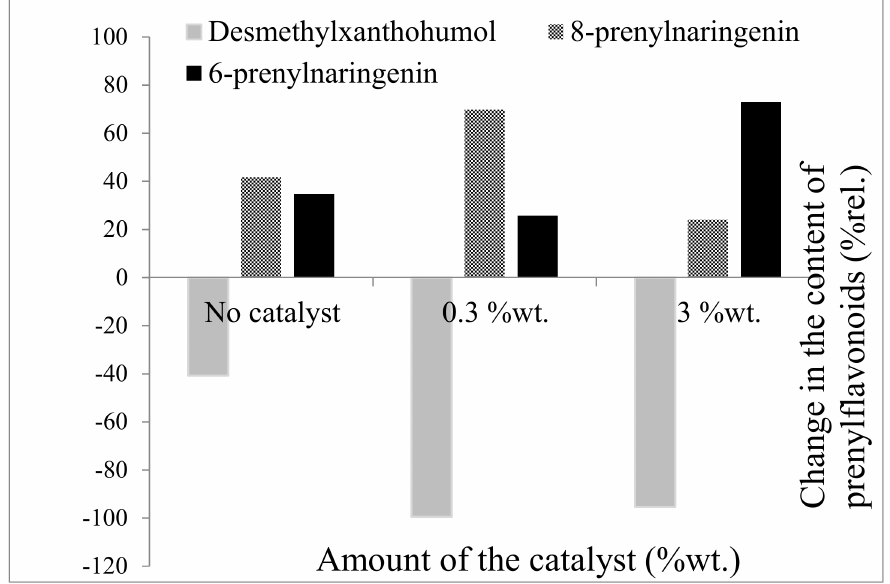
Figure 6. Catalyst-dependent changes in the content of prenylflavonoids after 9 days of isomerization relative to the content in starting